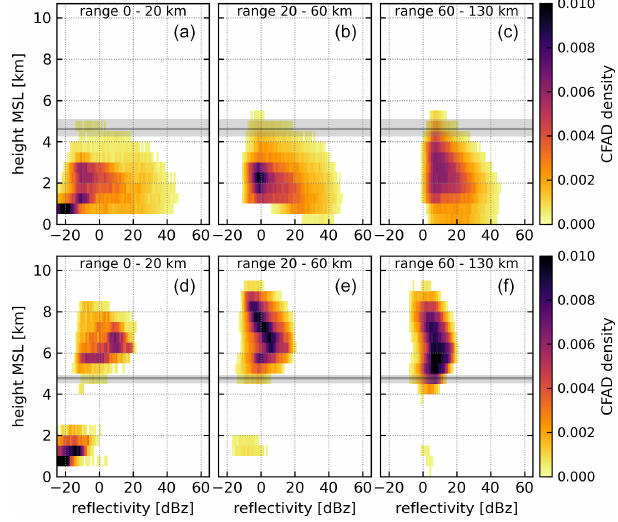
Figure 14. CFADs for 11 February (a) and 15 February 2020 (b) . Range intervals are 0–20, 20–60, and 60–130km. Horizontal gray bar and line indicate height range and mean value of the 0 ◦ C isotherm on those days.